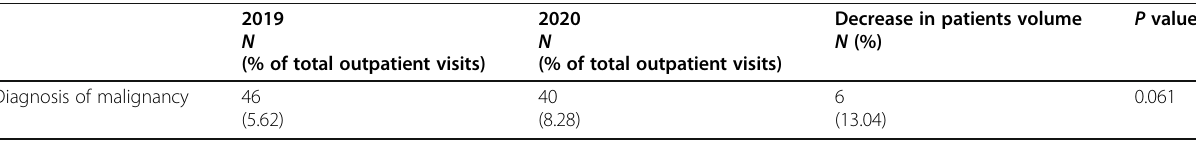
Table 4 Comparison of malignancy cases in outpatient visits between 2019 and 2020 2019 N (% of total outpatient